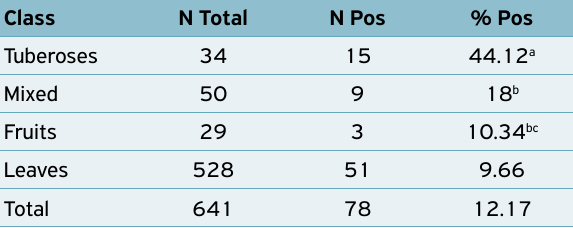
Table 2. Number and percentage of samples above the 10² MPN/g limit for coliforms at 45ºC, established by Resolution No. 12/01, divided by